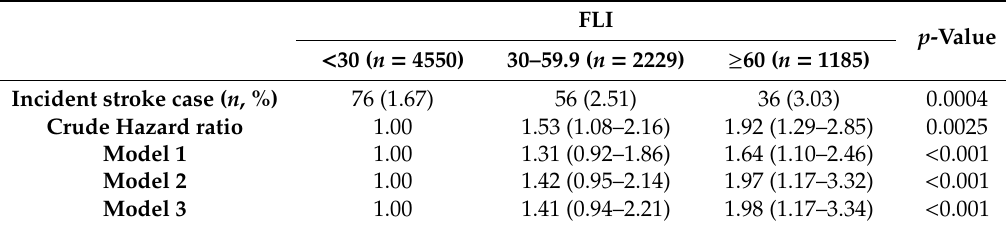
Table 2. Hazard ratio (95% confidence interval) for the incident of stroke according to the FLI groups.